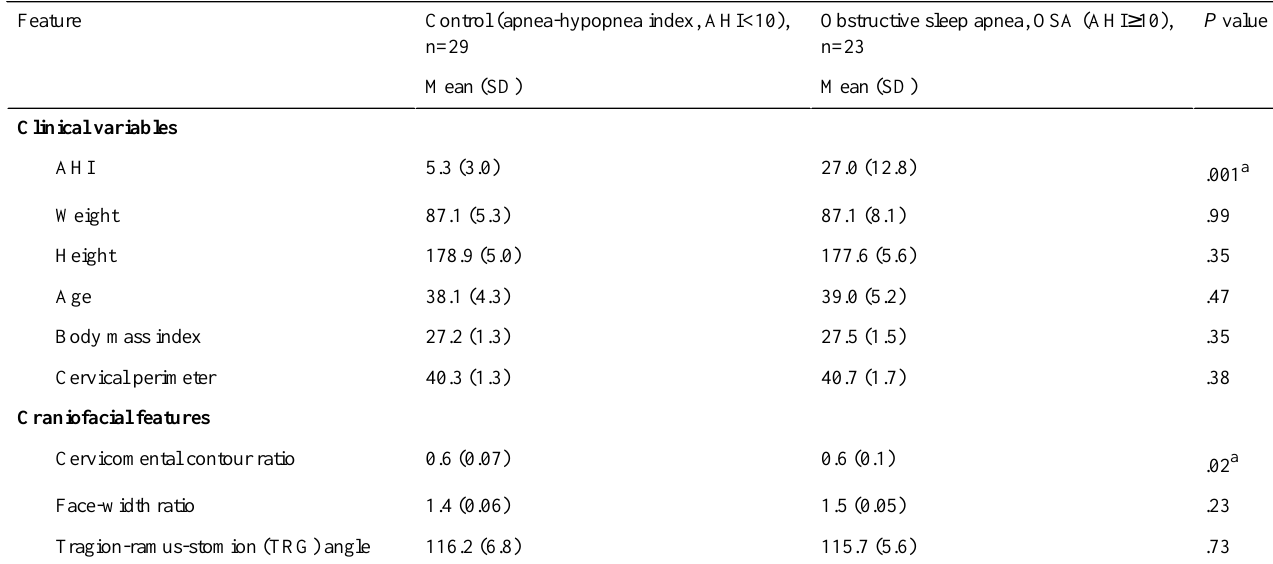
Table 12. Contrast between control and obstructive sleep apnea (OSA) groups on a subset without differences either on age ( ≤ 46) or on body mass index ( ≤ 30) on the male